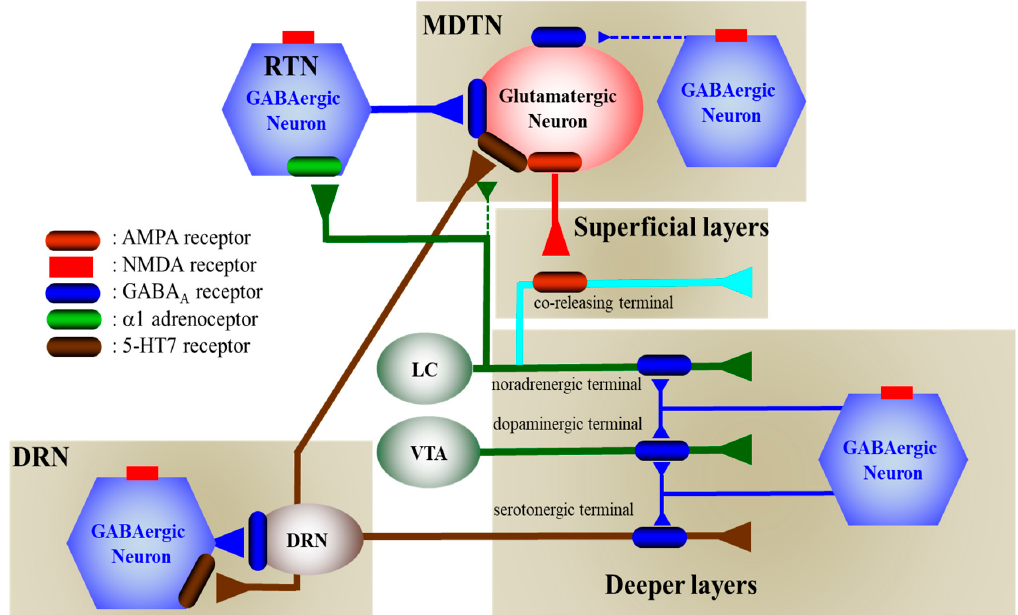
Figure 9. Proposed hypothesis for the extended neural circuitry involved in thalamocortical (RTN– MDTN–mPFC) glutamatergic, mesothalamic (DRN-MDTN), and mesocortical